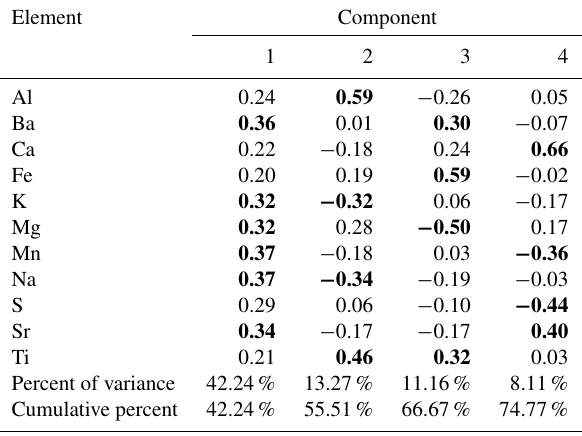
Table 2. Principal component loadings for the Mount Johns trace elements concentrations (PCA loadings > 0.3 are shown in